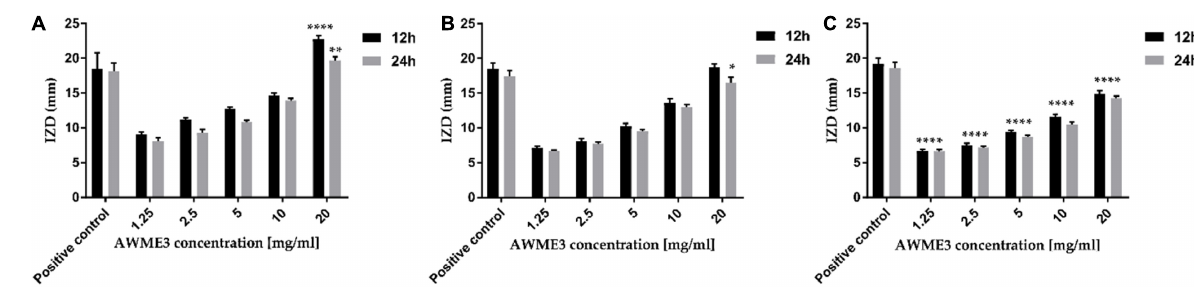
FIGURE 2 | Antimicrobial sensitivity of AWME3 against (A) K. pneumoniae ATCC BAA-2473, (B) K. pneumoniae KPM9, and (C) K. pneumoniae KPi1627 strains. The bacteria strains were subjected to concentrations of 1.25, 2.5, 5, 10, and 20 mg/mL of AWME3 from BSFL fat. The IZD values were measured after 12 and 24 h of incubation at 37 ◦ C. Doxycycline (DOX) used as a positive antibacterial control. All values are represented as mean ± SD, in triplicate ( n = 3). Data were analyzed by two-way ANOVA, followed by Dunnett’s Test. Data represented as significant difference as compared to positive control and p -value was ranged between. * p = 0.0138, ** p = 0.0062, **** p < 0.0001.